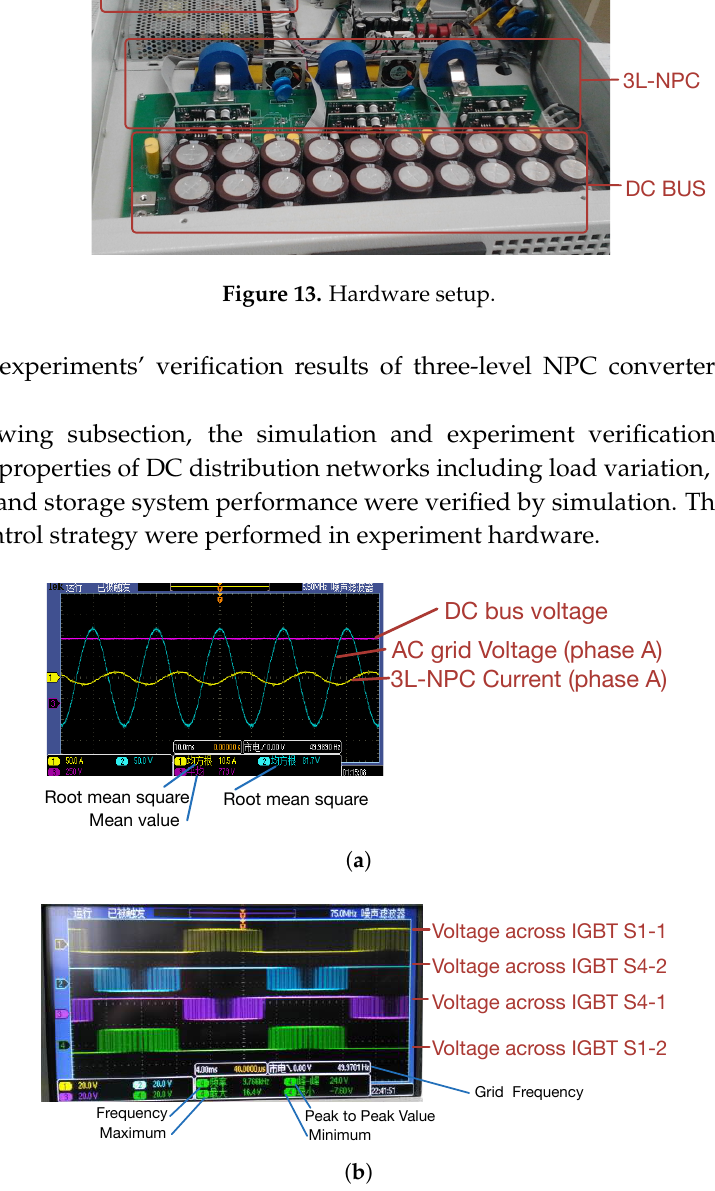
Figure 14. Experiment results. ( a ) three-level NPC converter output; ( b ) three level NPC PWM